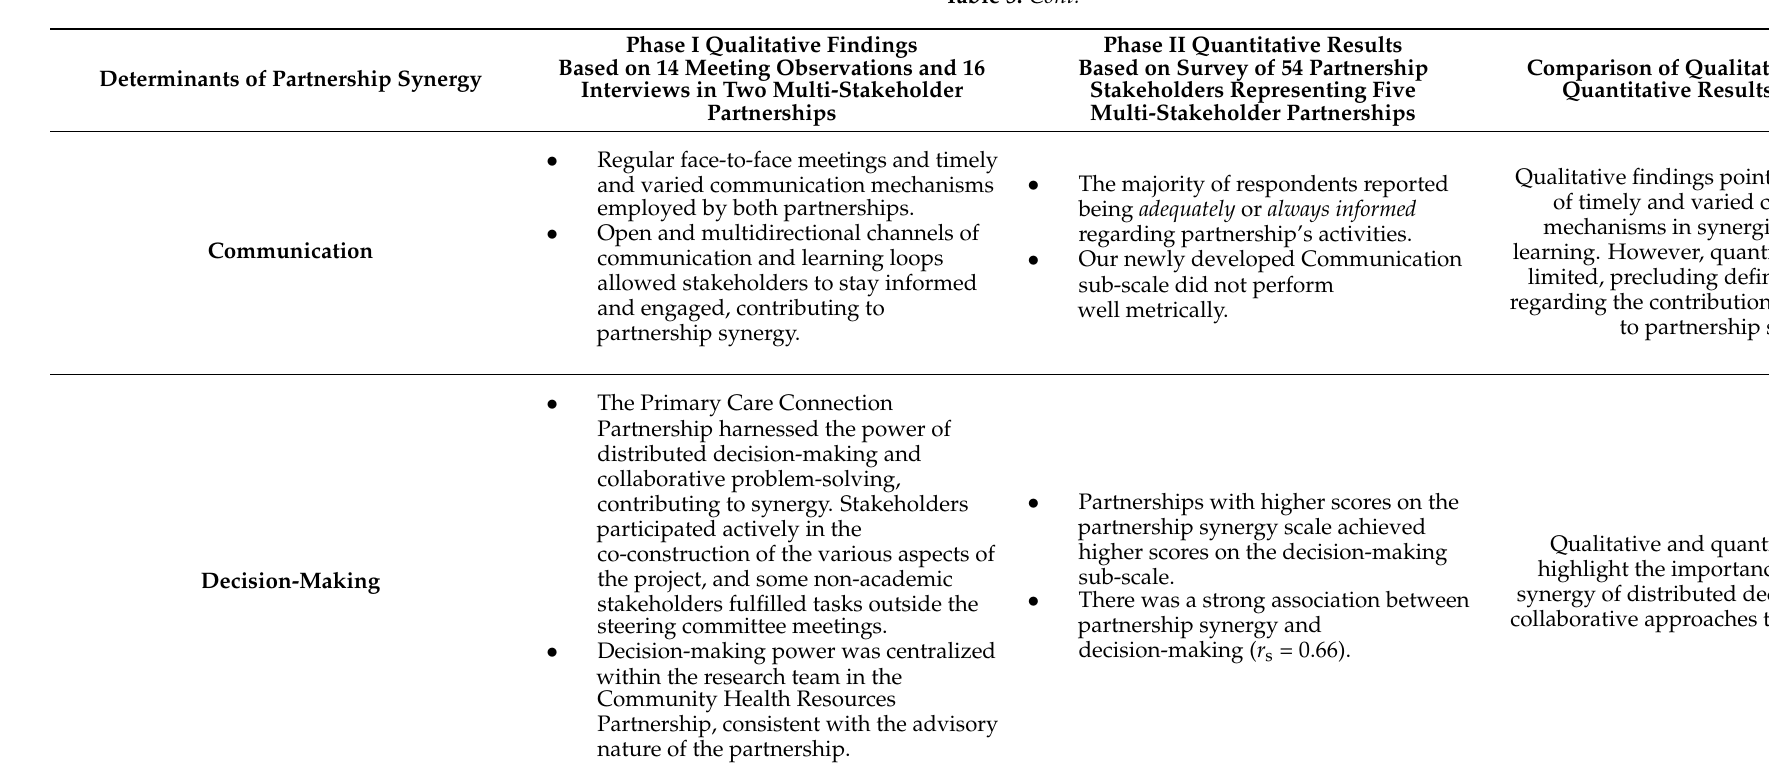
Phase I Qualitative Findings Based on 14 Meeting Observations and 16 Interviews in Two Multi-Stakeholder